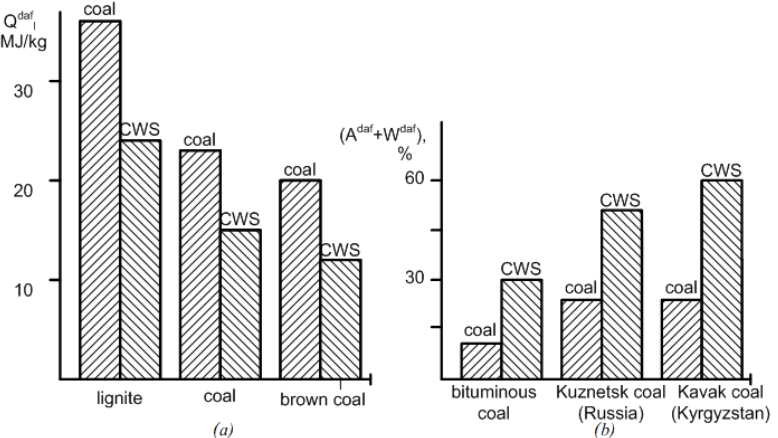
Figure 3. Comparison of the characteristics of dust and CWS of various coals: ( a ) heat of combustion; ( b ) total ballast of mineral inclusions and moisture.